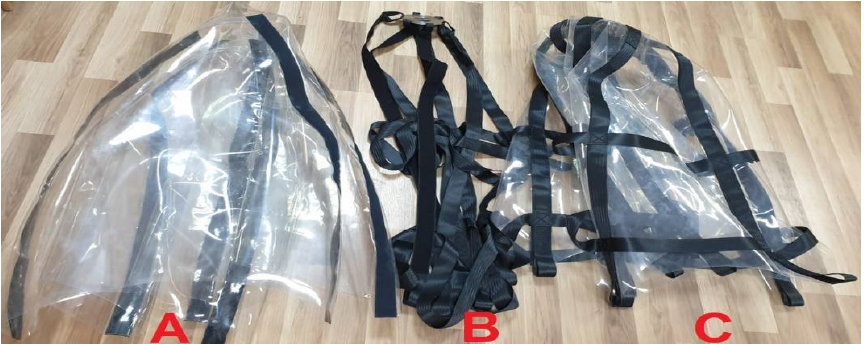
Figure 8. Batychron joining of main components: ( A ) transparent dome made of TPU material; ( B ) openwork mesh made of polyester belts; ( C ) Flexible diving bell—Batychron; Source: Own photos (2022).